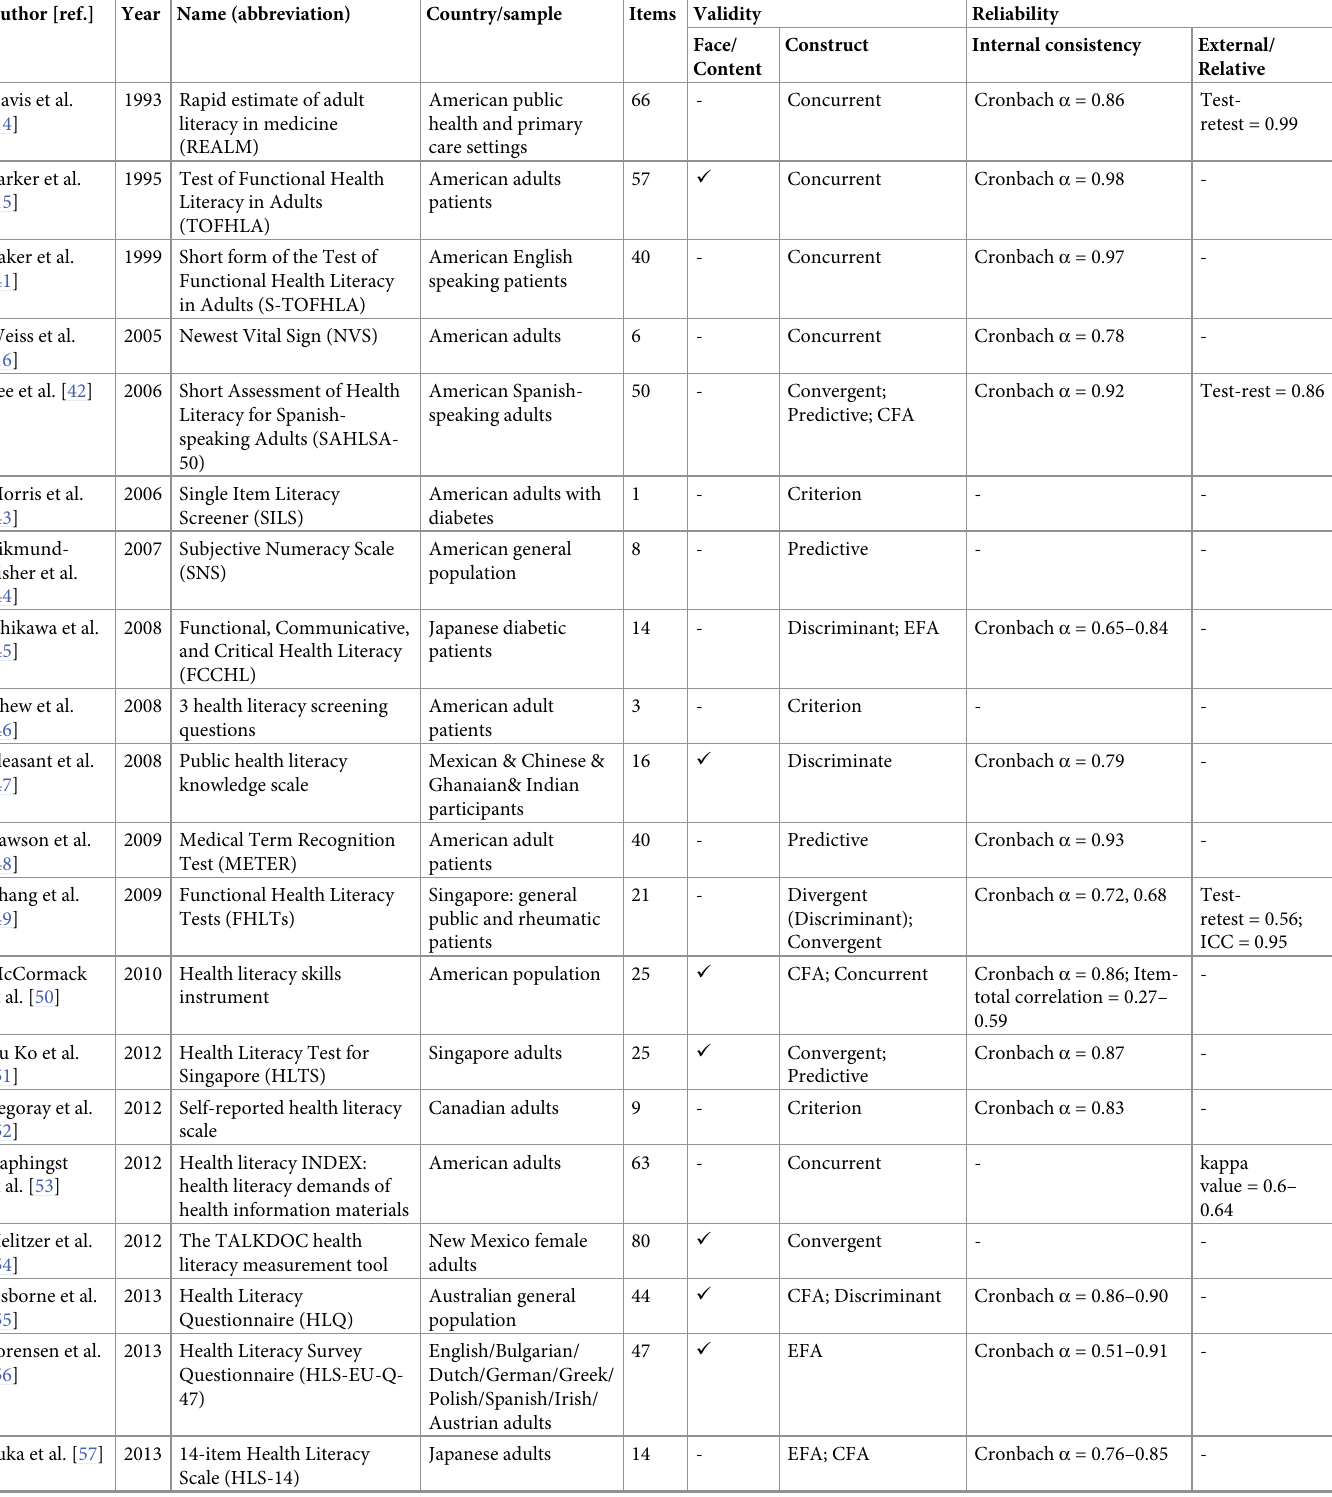
Table 2. General health literacy instruments